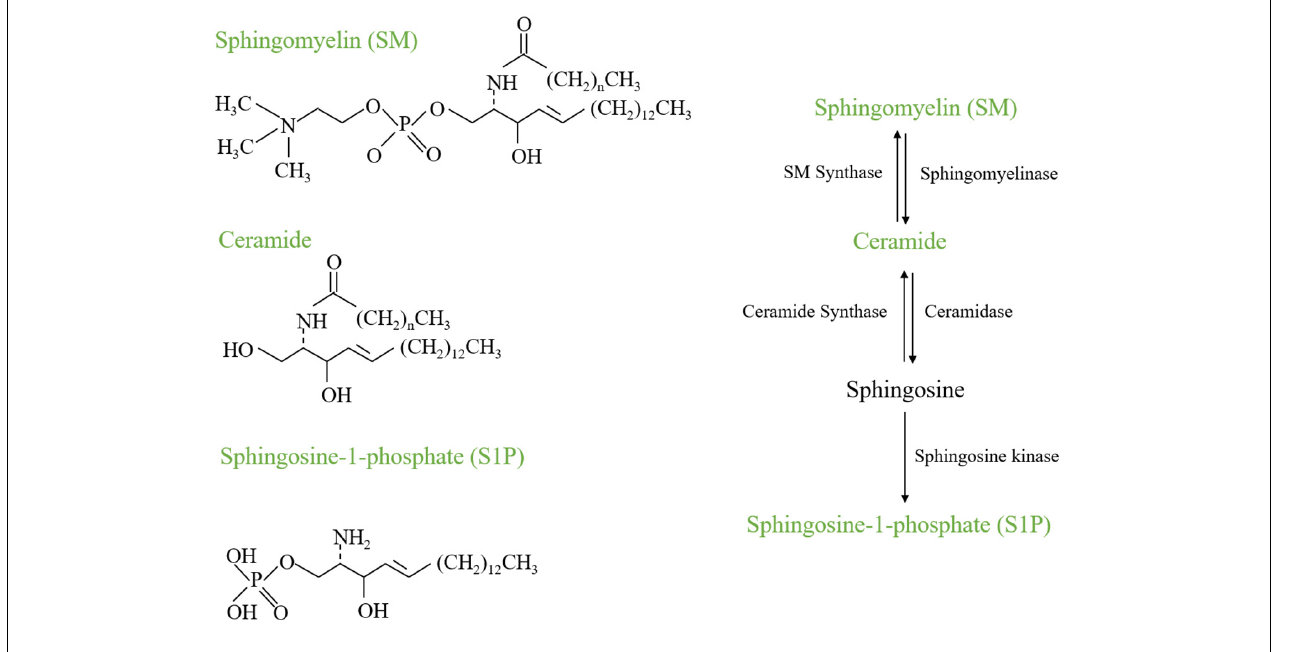
FIGURE 1 | Chemical structures and metabolism of SM, Ceramide, and